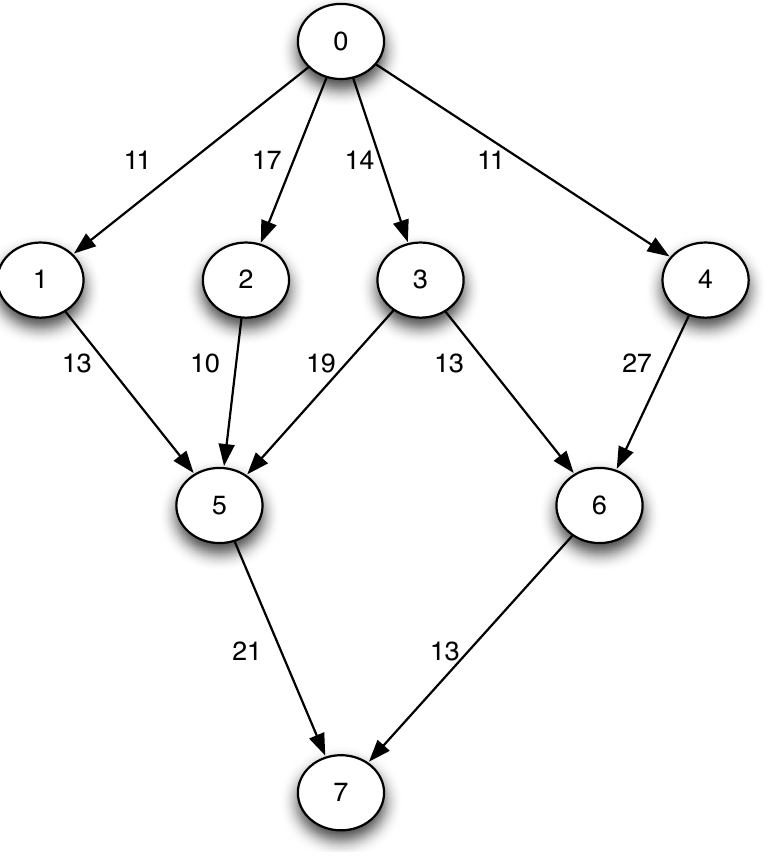
Figure 1. Precedence tasks graph G = ( T , C ) . Table 2. Computational times of the tasks at maximum capacity P i , j